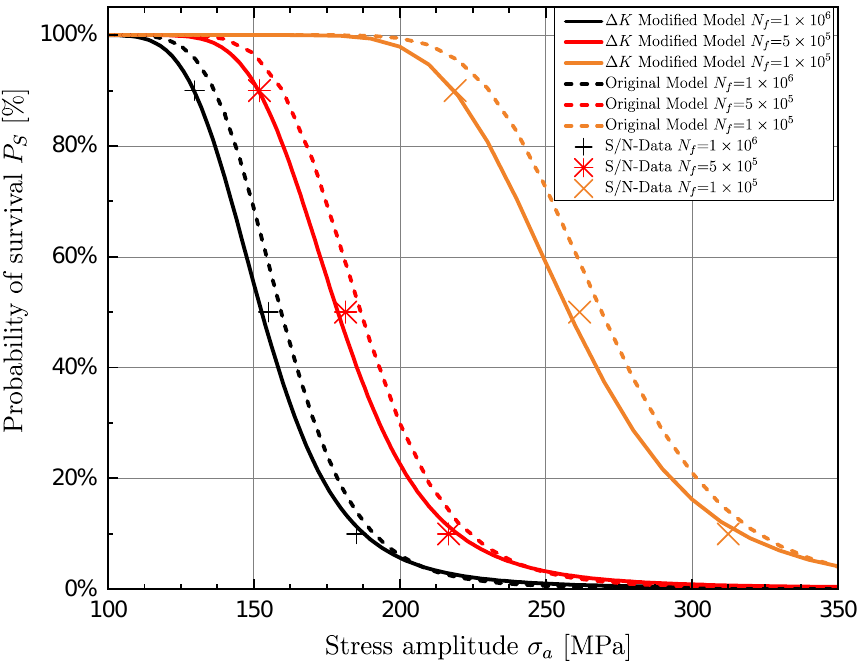
Figure 11. Model validation for constant load cycles. Table 8. Fatigue assessment model validation defined number of load